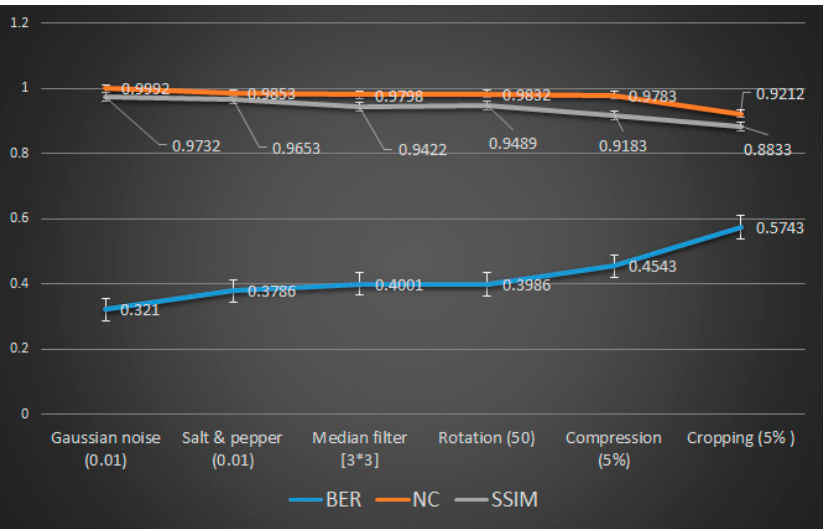
Figure 7. Robustness of proposed techniques corresponding to di ff erent